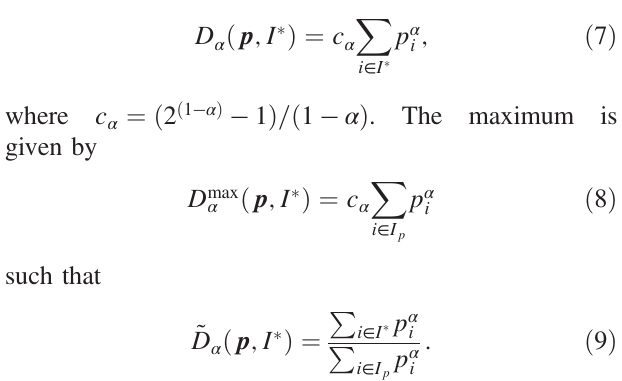
~ D p ; I (cid:2) Þ for two different changes. The α ð lines correspond to Eq. (9) with p i ∝ i − 1 with i ¼ 1 ; 2 ; … ; 1000 and two different sets of replaced symbols I (cid:2) 1 , I (cid:2) 2 . Right inset: 1 g ; i.e., only the symbol with the highest probability, I (cid:2) 1 ¼ f p ≈ 0 . 13 , is changed. Left inset: I (cid:2) 368 ; … ; 1000 g ; i ¼ 1 2 ¼ f i.e., the symbols with small probability are replaced. The P p ≈ p choice of I (cid:2) 2 was made such that i i ¼ 1 and i ∈ I (cid:2) 2